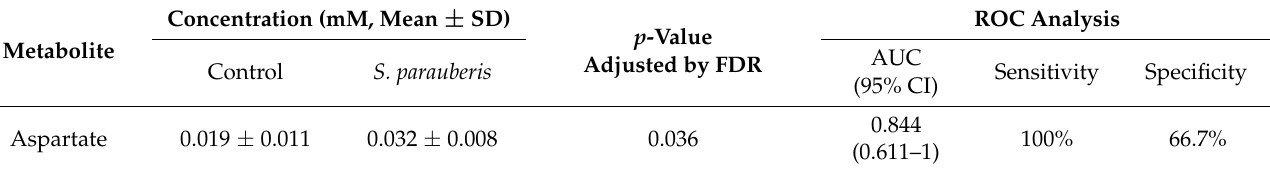
Table 1. Significantly changed metabolites in the spleen of fish infected with S. parauberis .